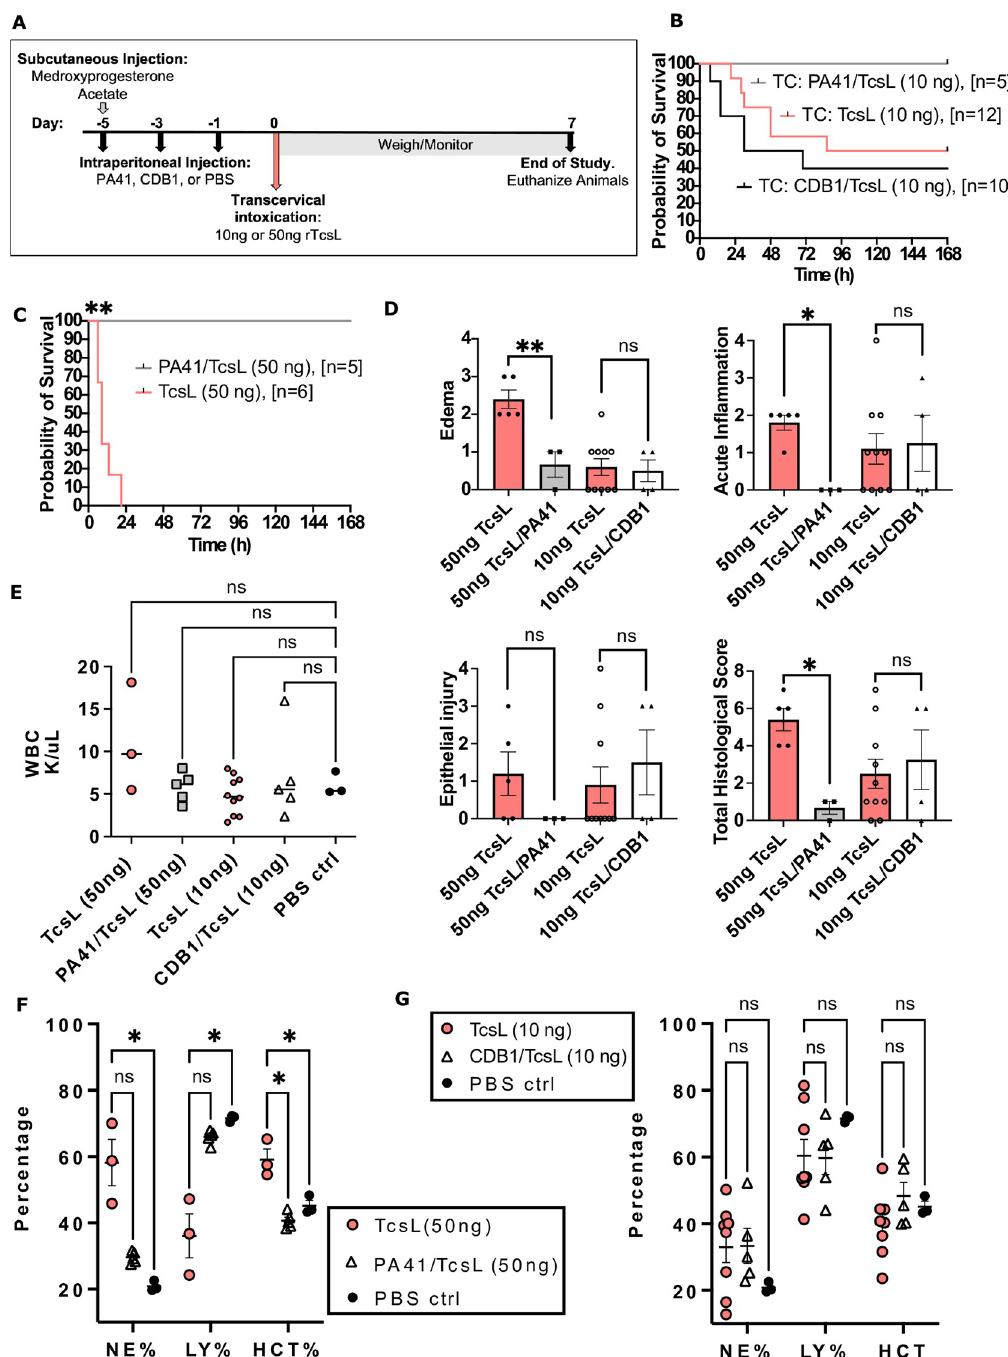
Fig 5. Neutralization studies of monoclonal antibodies, PA41 and CDB1, following transcervical intoxication of rTcsL. (A) Timeline of neutralization studies: subcutaneous administration of medroxyprogesterone acetate on Day -5 to induce diestrus. Intraperitoneal injections of 7.5 mg/kg PA41, 7.5 mg/kg CDB1, or PBS on Days -5, -3, -1. Transcervical intoxication of rTcsL on Day 0. Animals weighed/monitored for seven days. (B) Survival curve of animals in diestrus treated with PA41 or CDB1 on days -5, -3, -1, and transcervically intoxicated with 10ng TcsL on Day 0. (C) Survival curve of animals in diestrus treated with PA41, on days -5, -3, -1, and transcervically intoxicated with 50ng TcsL on Day 0. Log-rank (Mantel-Cox) multiple comparison test was used with statistical significance set at a p value of < 0.05. (D) Histological scoring of edema, acute inflammation, and epithelial injury of uterine tissues at time of death or end of study from mice transcervically instilled with 50ng TcsL in the presence or absence of PA41 and 10ng TcsL in the presence of absence of CDB1. Mann-Whitney test was used